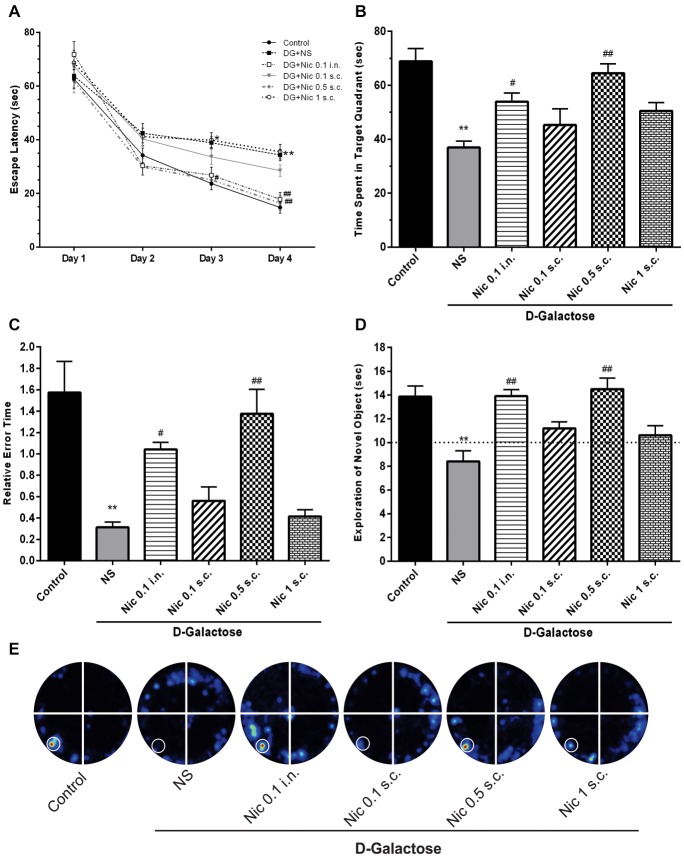
Learning and memory profile in study groups. (A) Mean escape latency time during 4 days of training session of MWM, (B) mean time spent in the target quadrant in the probe trial session of MWM, (C) mean relative error time in the probe trial session of MWM, (D) exploration time of the novel object during the retention session of NOR test, (E) corresponding heat maps show the combined traces of the mice from each group during the probe test of MWM (left lower part was considered as target quadrant). Values represent the mean ± SEM, (n = 12). Significant differences tested by two- (A) or one-way ANOVA followed by Tukey’s post hoc test; *p < 0.05 and **p < 0.01 compared to the control group. #p < 0.05 and ##p < 0.01 compared to the DG+NS group; NS, normal saline; DG, D-galactose; Nic, nicotine; s.c., subcutaneous; i.n., intranasal; MWM, Morris water maze; NOR, novel object recognition.